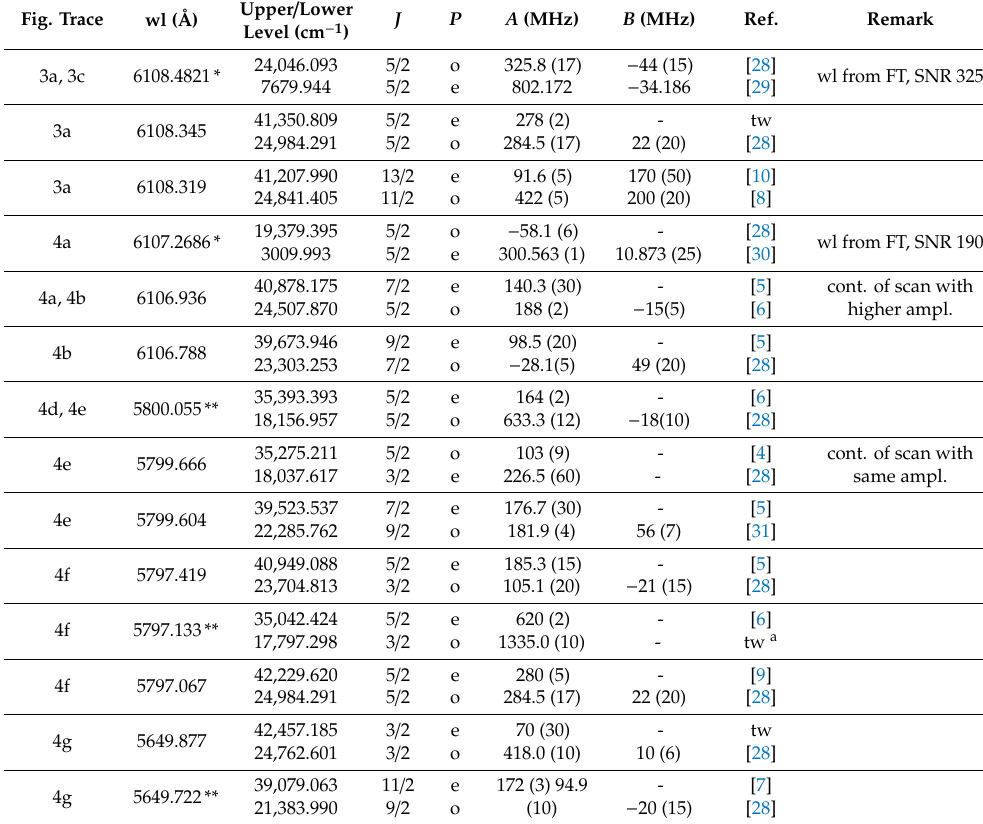
Table 1. Data for the lines shown in Figures 3 and 4. All lines were previously unknown, with exception of the line at 6107.2686 Å (trace 4a). * wavelength from the Fourier-transform (FT) spectrum [22,23]. ** wavelength calculated from level energies. The other wavelengths were determined from SNR—signal-to-noise ratio in the FT spectrum. cont—continuation. ampl—amplification of the used lock-in amplifier. In column “Ref.” the source of the hf constants A and B of the levels is